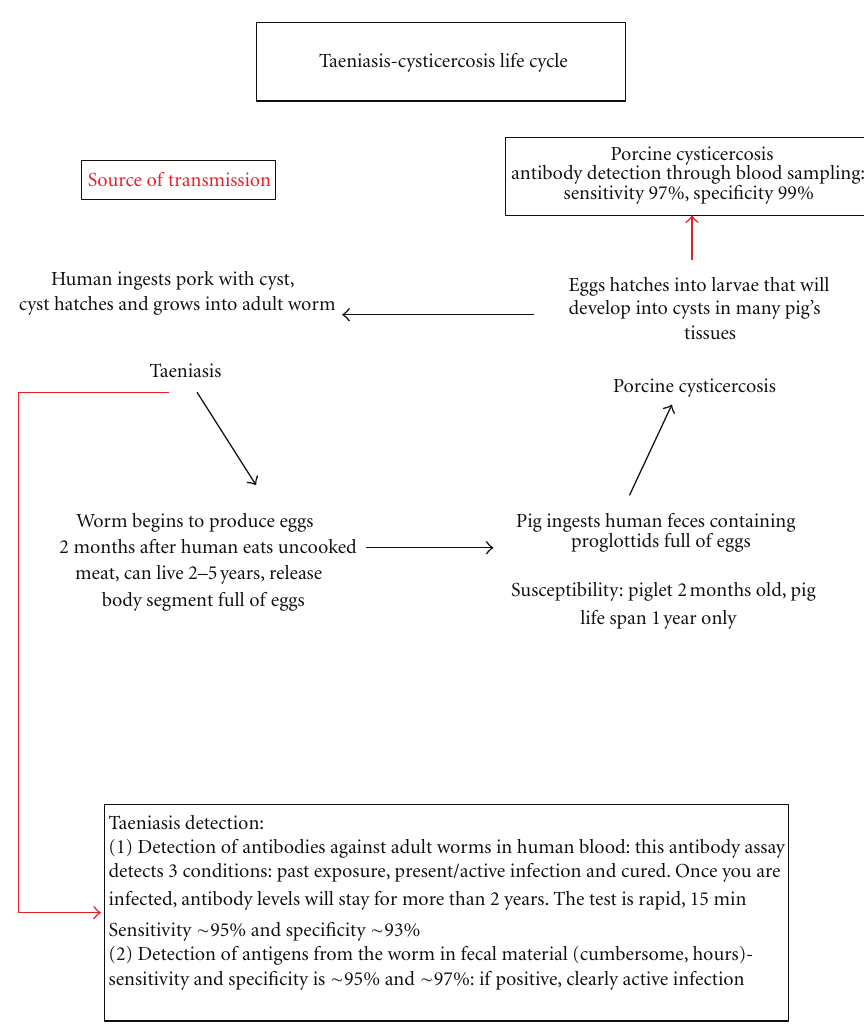
Figure 1: Taeniasis-cysticercosis life cycle and means of